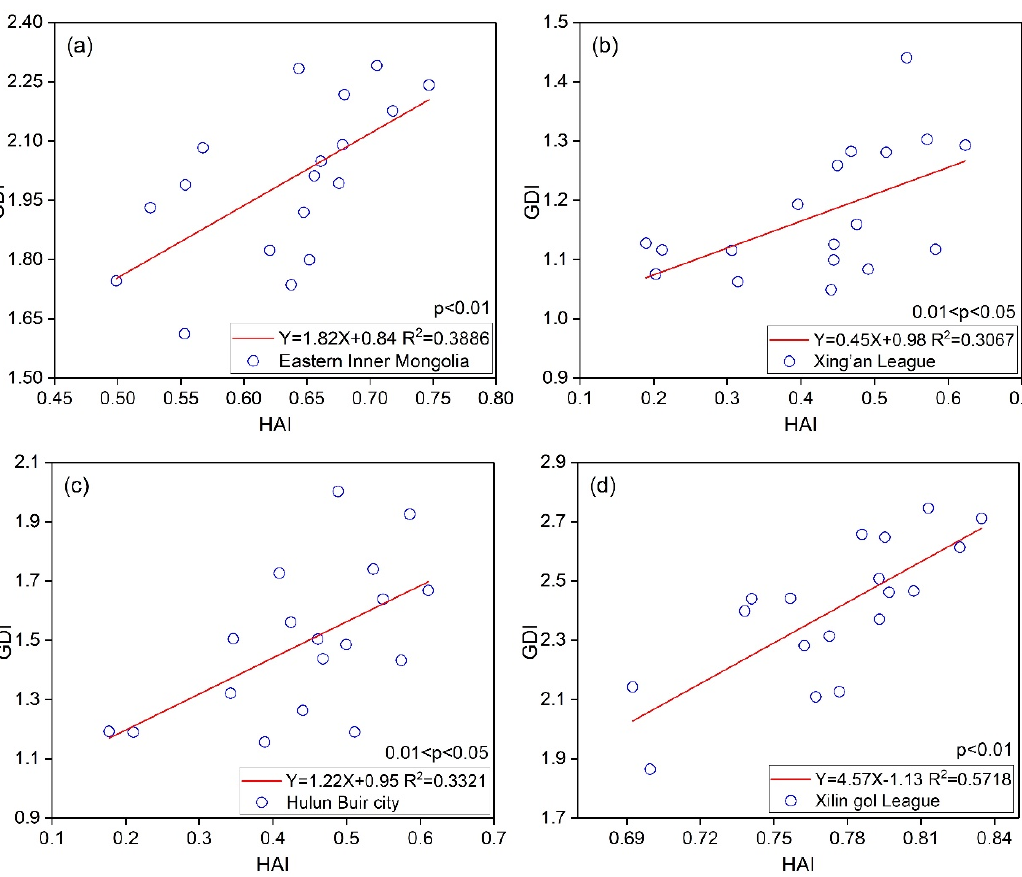
Figure 9. Relationship between HAI and grassland degradation in eastern Inner Mongolia ( a ), Xing’an League ( b ), Hulunbuir City ( c ), and Xilingol League ( d ).